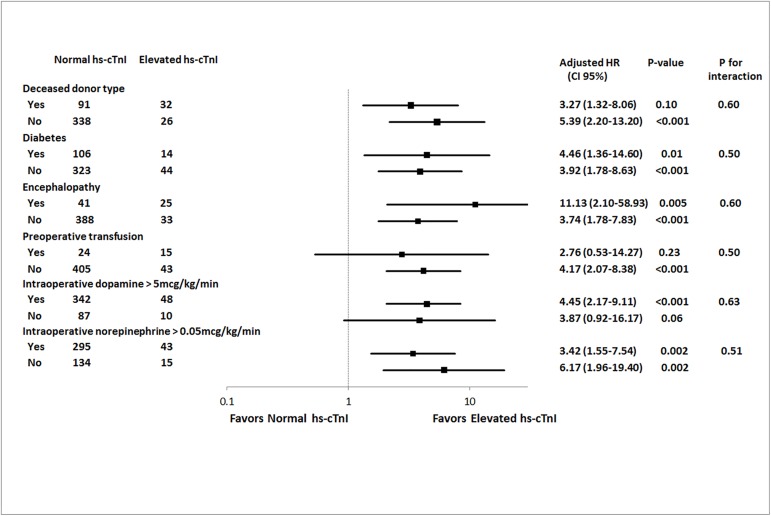
Subgroup analysis of deceased donor type, diabetes mellitus, encephalopathy, preoperative transfusion, intraoperative dopamine use and intraoperative norepinephrine use for all-cause death in 1-year.